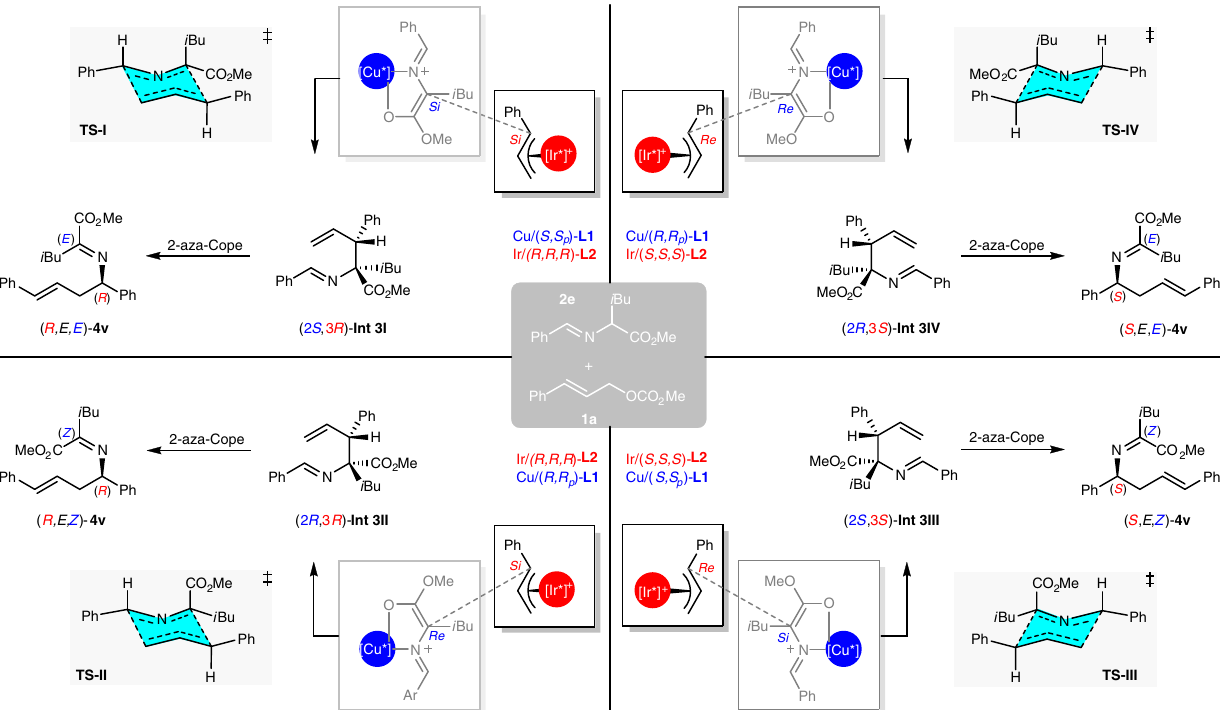
Fig. 4 Conformational analysis. Different possible approaches between the prochiral faces of Cu(I)-stabilized azomethine ylide and Ir- π -allyl complex in the stereodivergent controlled C – C bond formation and the stereospeci fi c chirality transfer of the 2- aza -Cope rearrangement via the favored chair-like transition